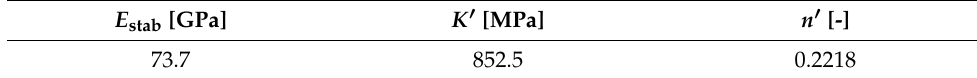
Table 4. Parameters of the cyclic curve of AlSi10Mg alloy.